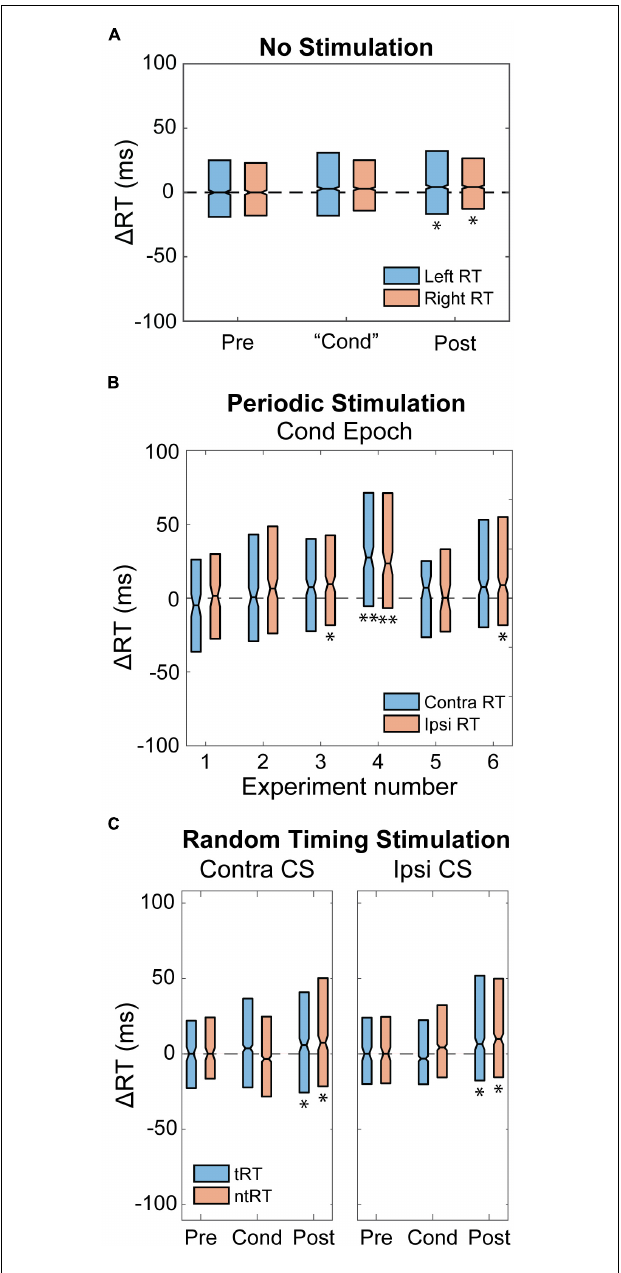
FIGURE 7 | Control Experiments. (A) RT relative to the Pre epoch when delivering no stimulation during the “Cond” epoch. The “Cond” epoch was determined using the number of trials. RT slows over time for both limbs and becomes significant by the Post epoch. There was no significant difference between the two limbs. Significance is compared to zero ( ∗ p < 0.01). (B) Periodic stimulation delivered to one hemisphere did not have consistent changes or produce differential effects in RT associated with either hand. Plots show six different experiments with Monkey I and corresponding change in RT. Contra and Ipsi RT are with respect to the stimulated hemisphere. Significance is compared to zero ( ∗ p < 0.01; ∗∗ p < 0.001). (C) Random stimulus timing delivered to both the movement generating (Contra CS) and non-movement generating (Ipsi CS) hemisphere. There is greater variability in RT compared to the no stimulation condition, but median changes were similar. Significance is compared to zero ( ∗ p <